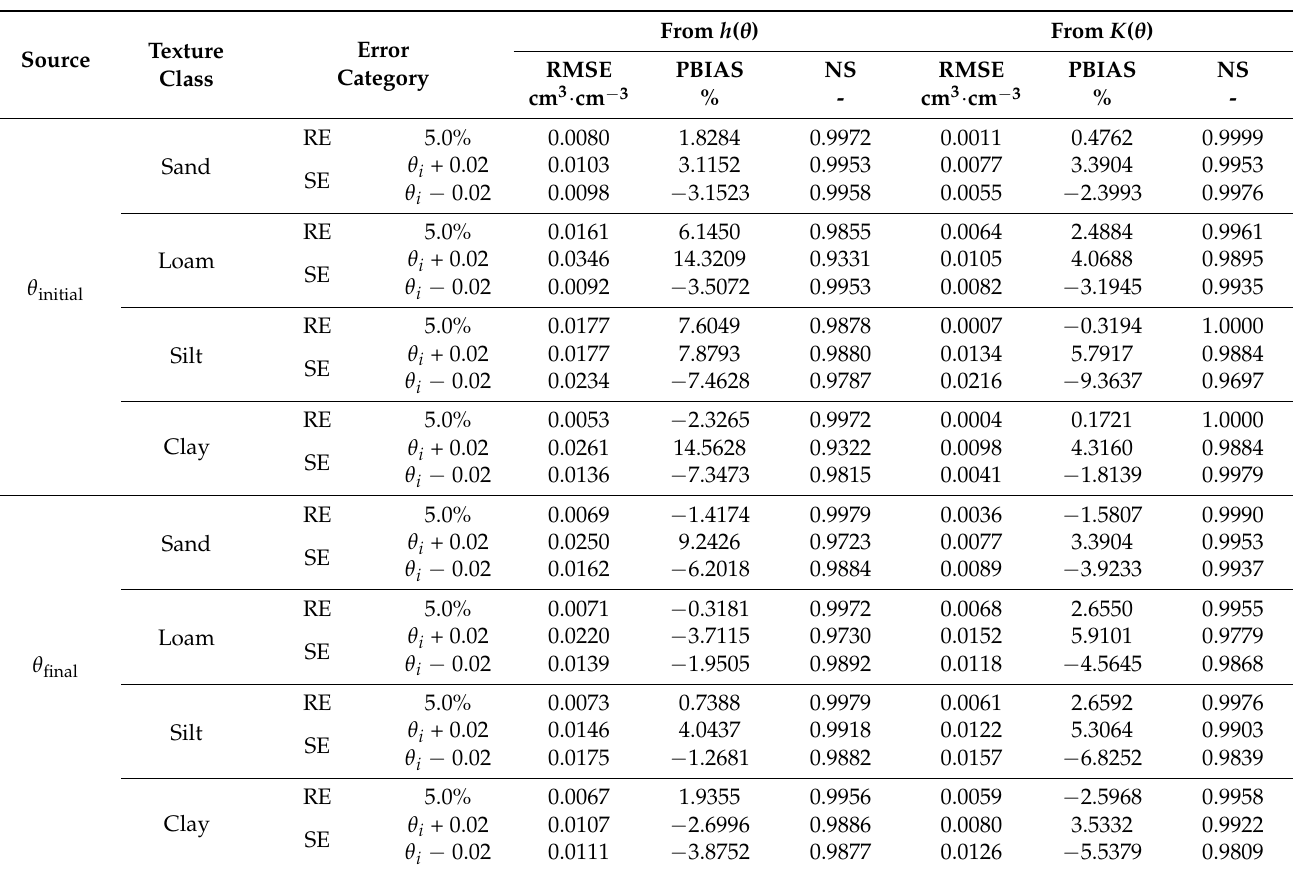
Table 6. Soil water content errors calculated from inverted SWRCs and diffusivity curves given the system and random errors in initial and final water content levels for the four typical soils.